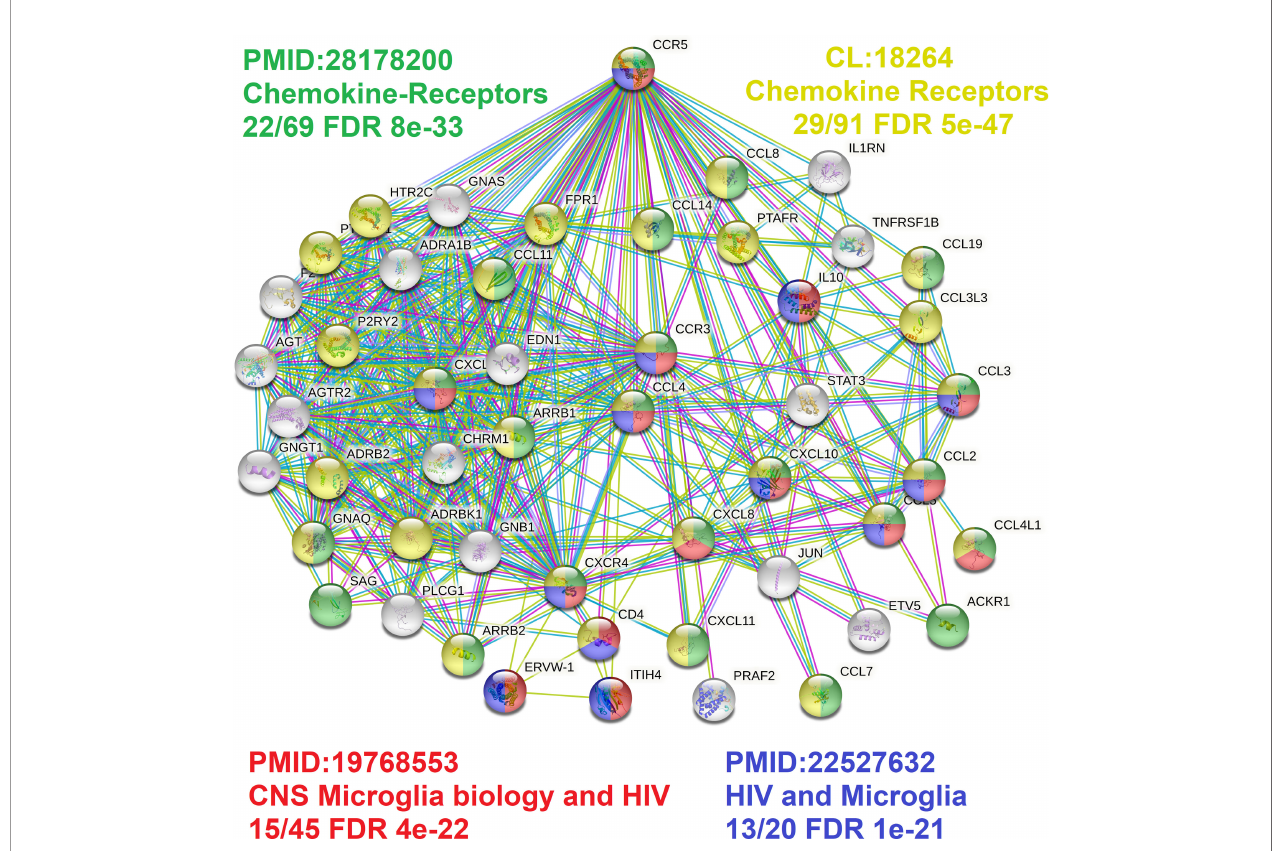
FIGURE 6 | CCR5 protein network highlighting microglia factors. The STRING protein network for the top 50 proteins interacting with CCR5. In green/yellow are various genes annotated to chemokine biology, and in red/blue are genes connected to microglia